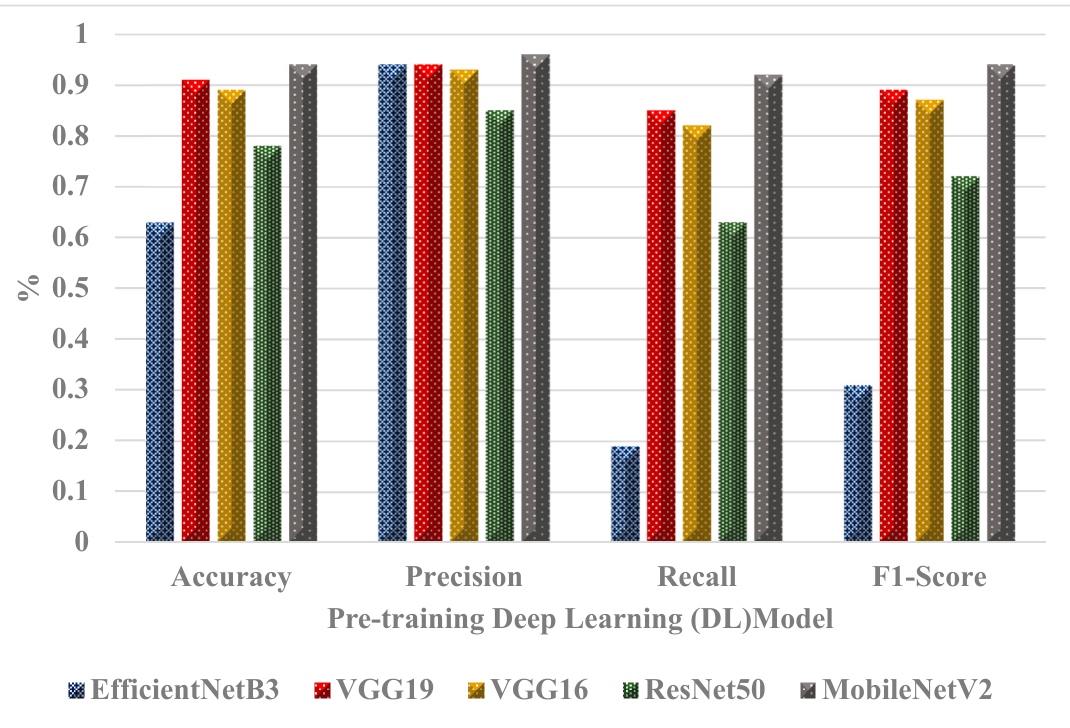
Figure 7. Performance of the classifier models.